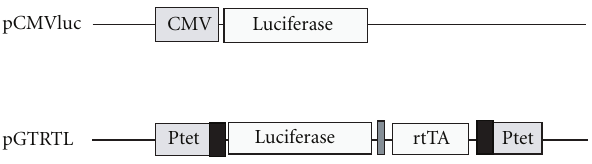
Figure 1: Plasmid Constructs. Schematic representations of firefly luciferase coding constructs used in this study. Promoters are outlined in grey.